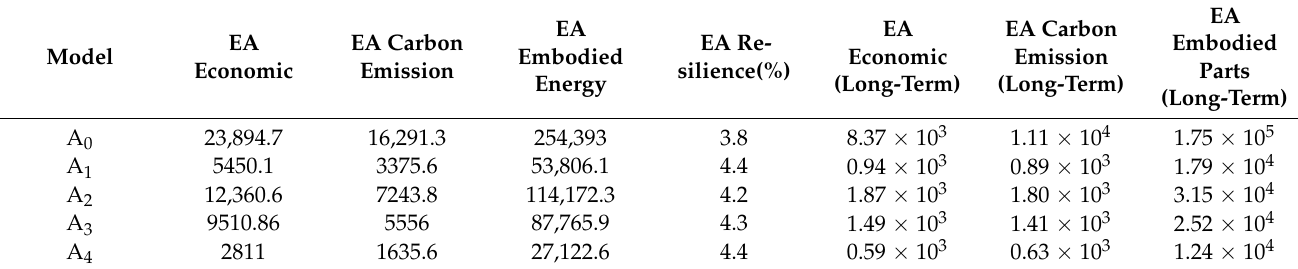
Table 2. Decision matrix for PB–MCDM [49], also using long-term consequences.